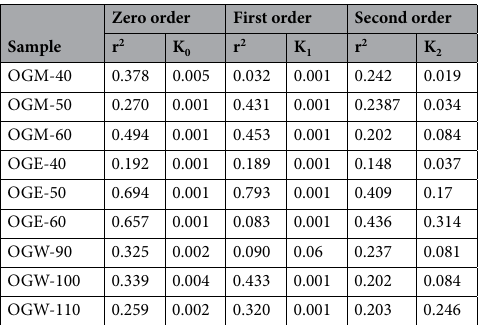
Zero order First order Second order Sample r